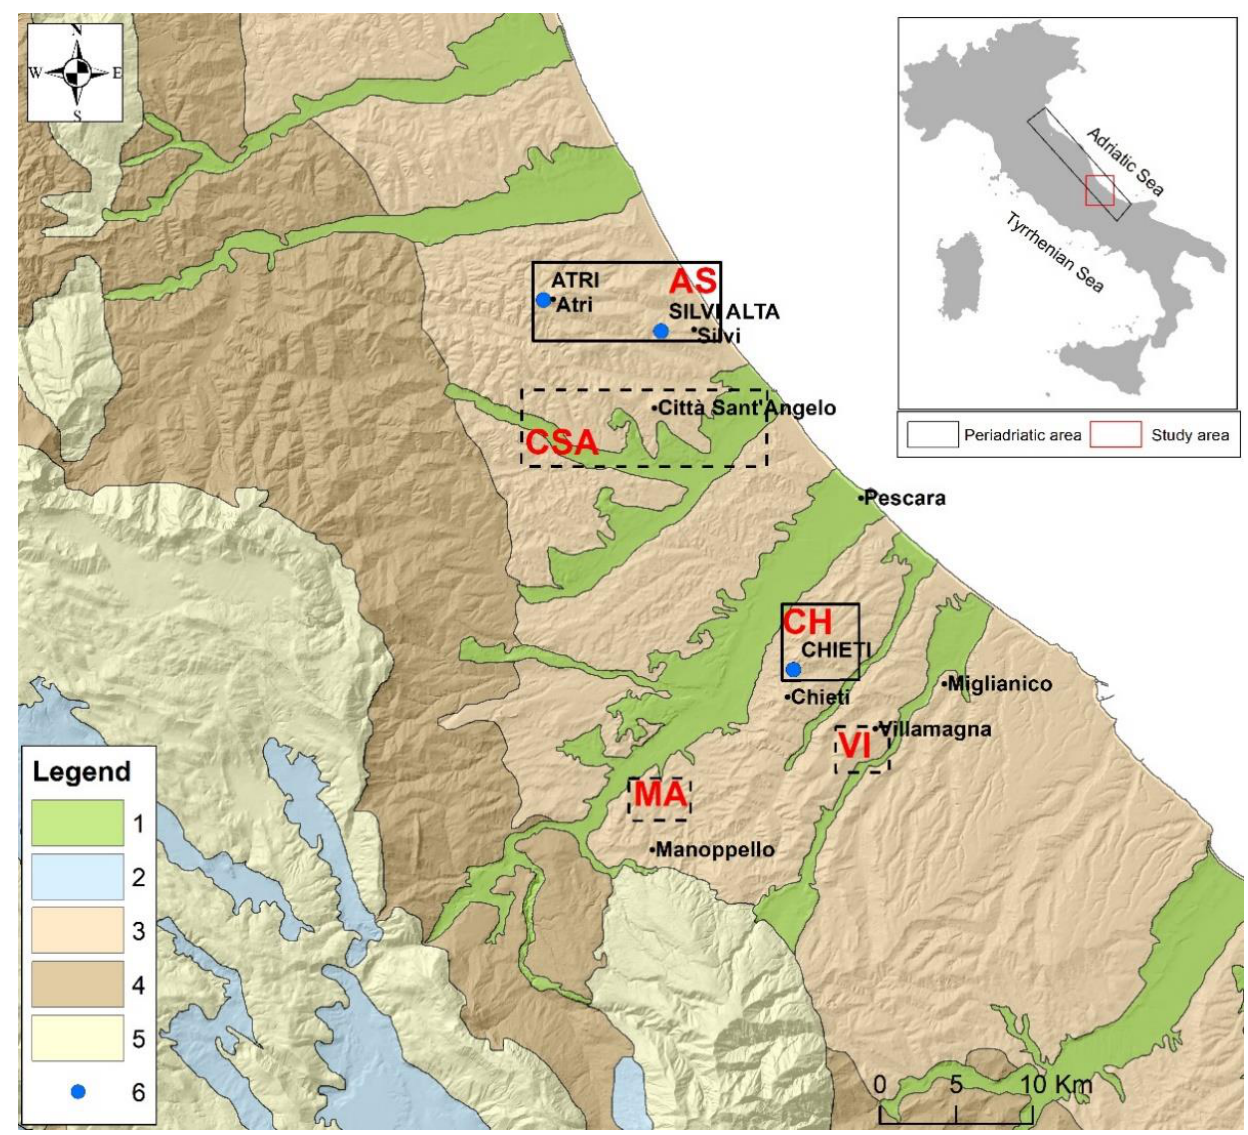
Figure 1. Regional geological framework of the aquifers. (1) Alluvial deposits of the main rivers and (2) of inland intermontane basins; (3) foredeep basin deposits; (4) turbiditic deposits; (5) carbonate deposits; (6) location of the meteoro- logical